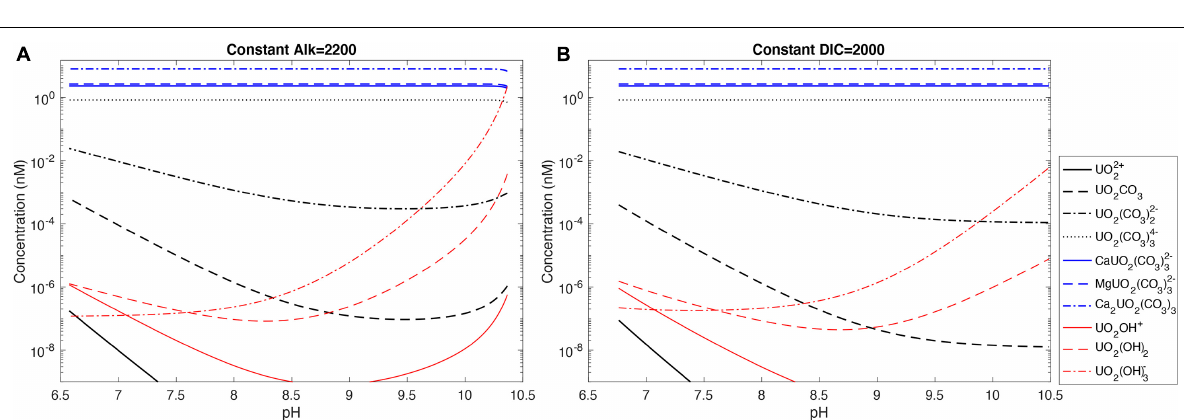
FIGURE 4 | U/Ca correlations with (A) Mg/Ca, (B) Sr/Ca, (C) δ 18 O and (D) δ 13 C in bulk D. dianthus samples listed in Table 1 . The corals are grouped according to their environmental conditions, with a threshold temperature of 5 ◦ C and aragonite saturation state ( (cid:127) A ) of 1.